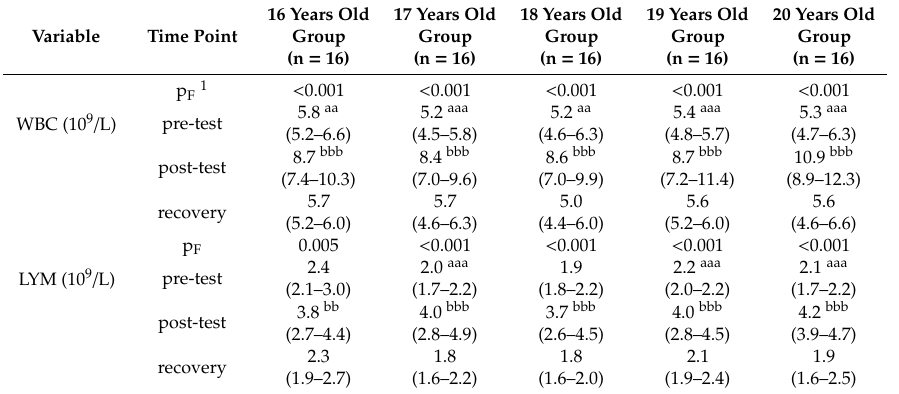
Table 4. White blood cell (WBC), and lymphocyte (LYM) counts of studied participants’ blood